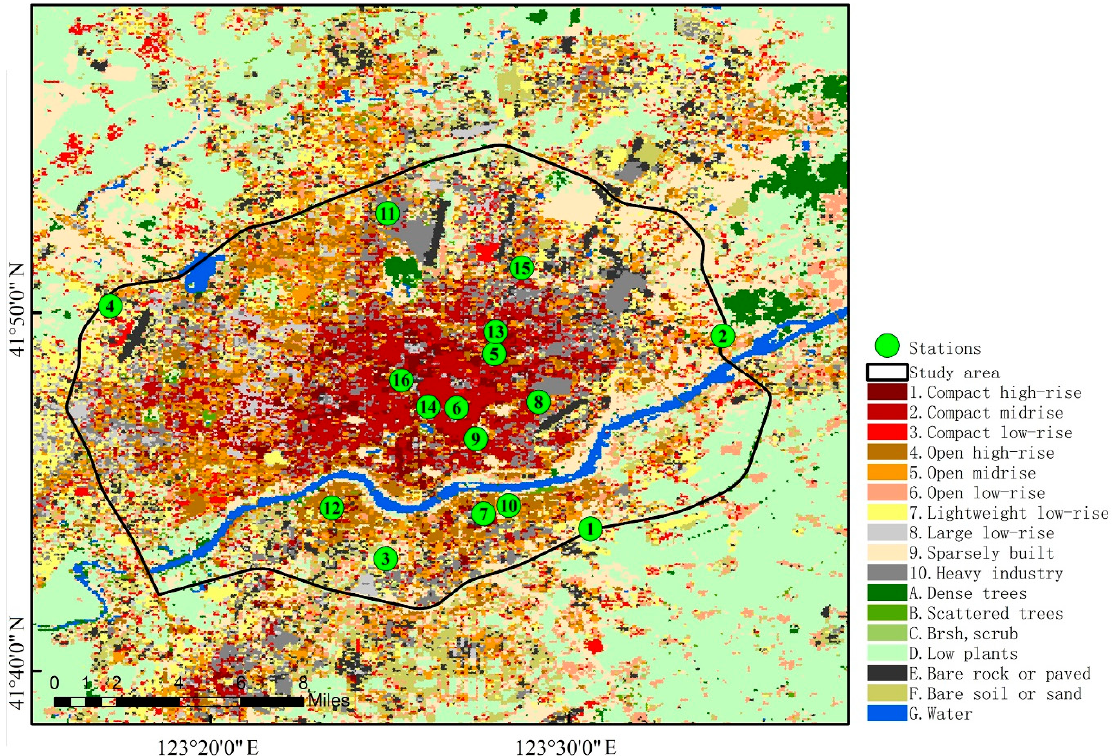
Table 1. A description of the LCZ types and images of case study areas.